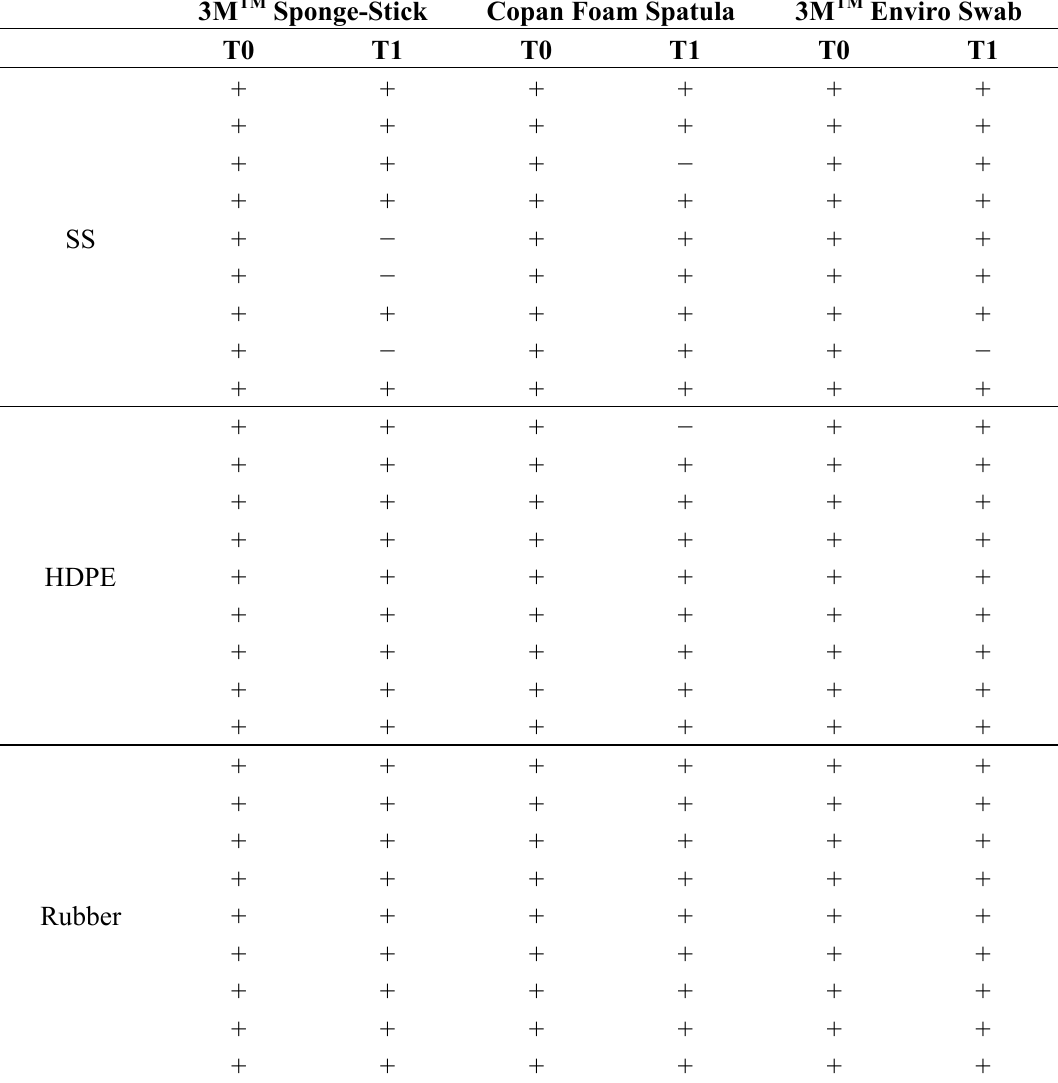
Table 1. Results of the different swabbing devices when used for swabbing on stainless steel (SS), high density poly-ethylene (HDPE) and rubber. T0 is the sampling time immediately after inoculation, whilst the surface was still wet. T1 is the sampling time when the surface had been allowed to air-dry for 1 h at room temperature. “+” is used when the swabbing device could detect L. monocytogenes . “ − ” is used when the swabbing device could not detect L. monocytogenes